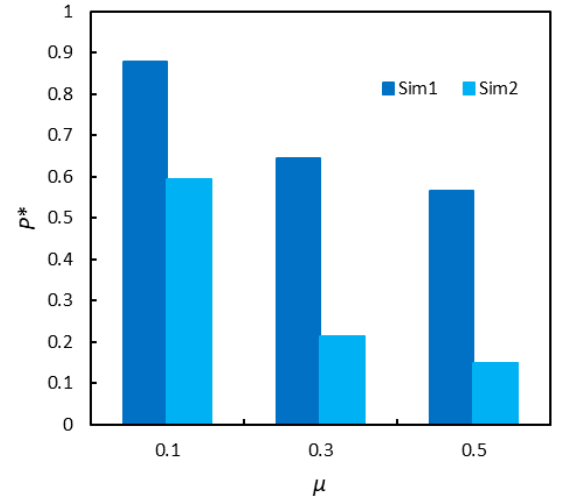
Figure 10. Pressure at the bottom upon varying the friction coefficient.